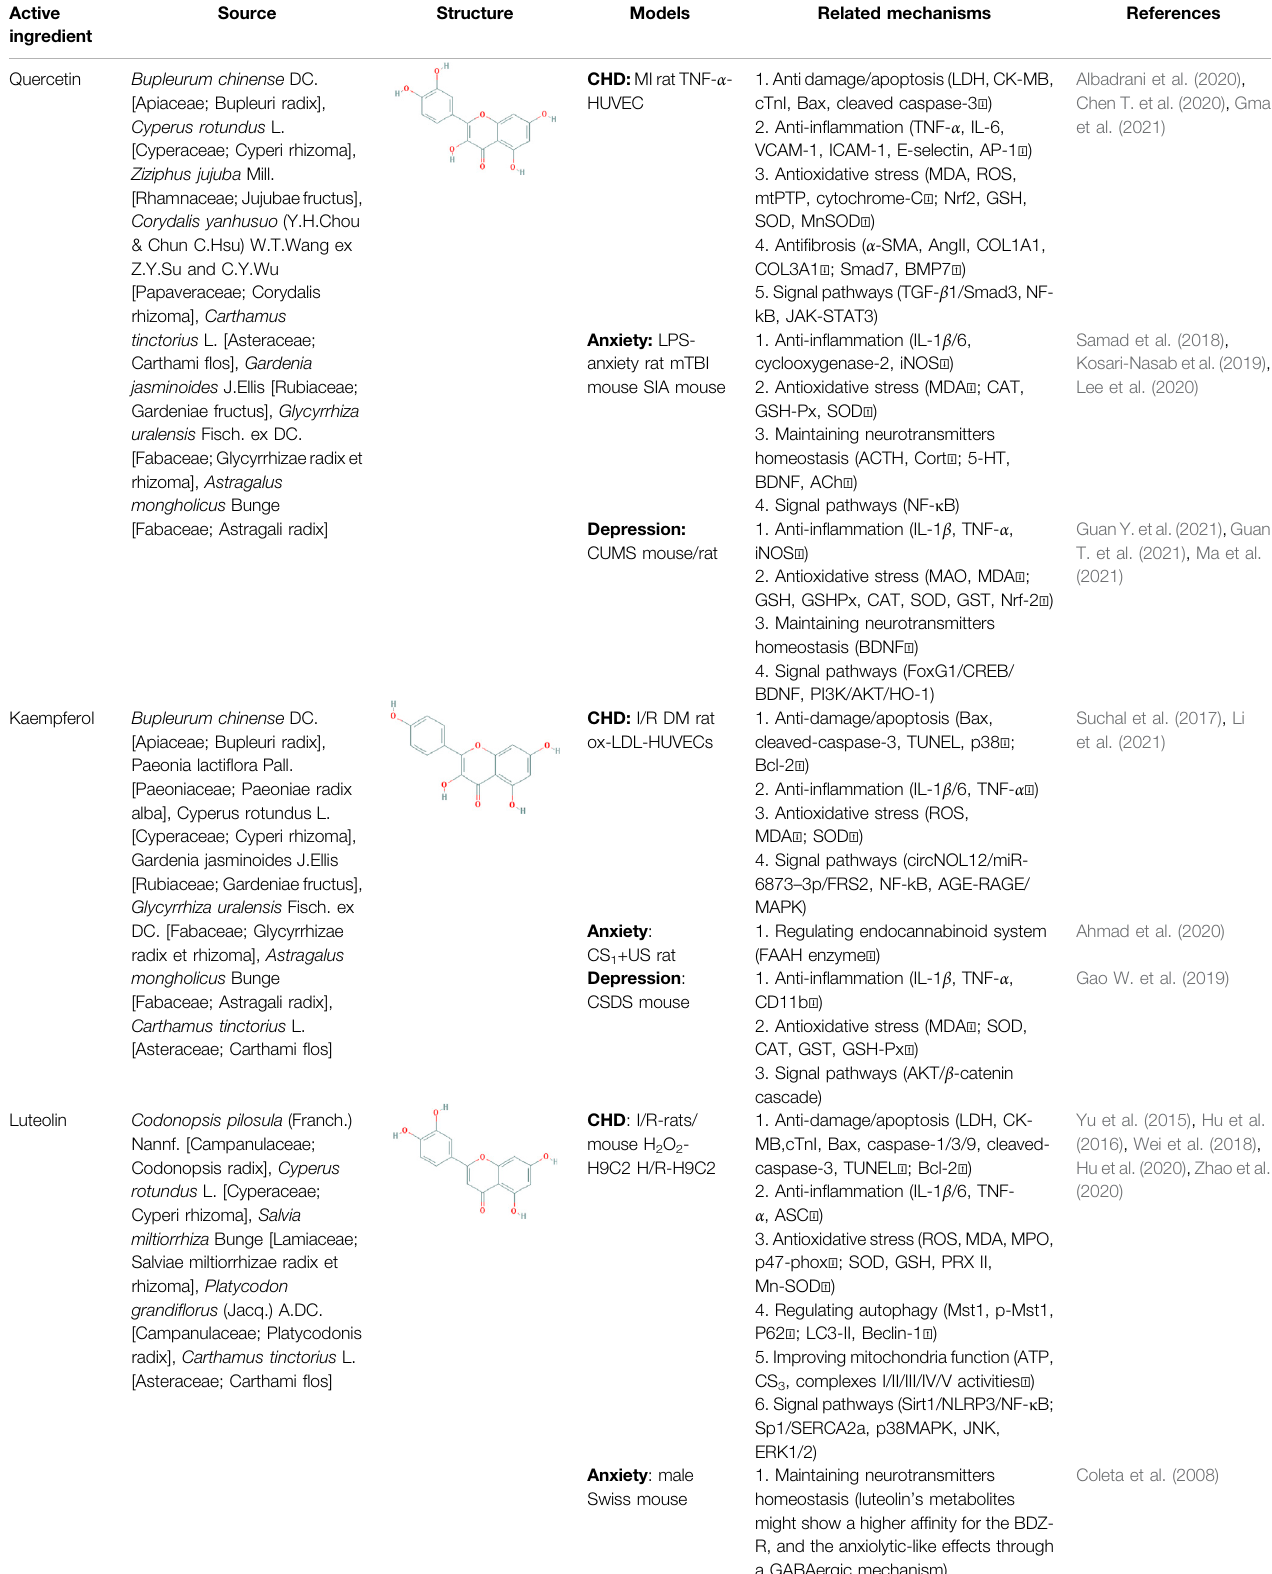
TABLE 3 | Mechanisms of main active components of CHM on CHD with anxiety or depression. Active